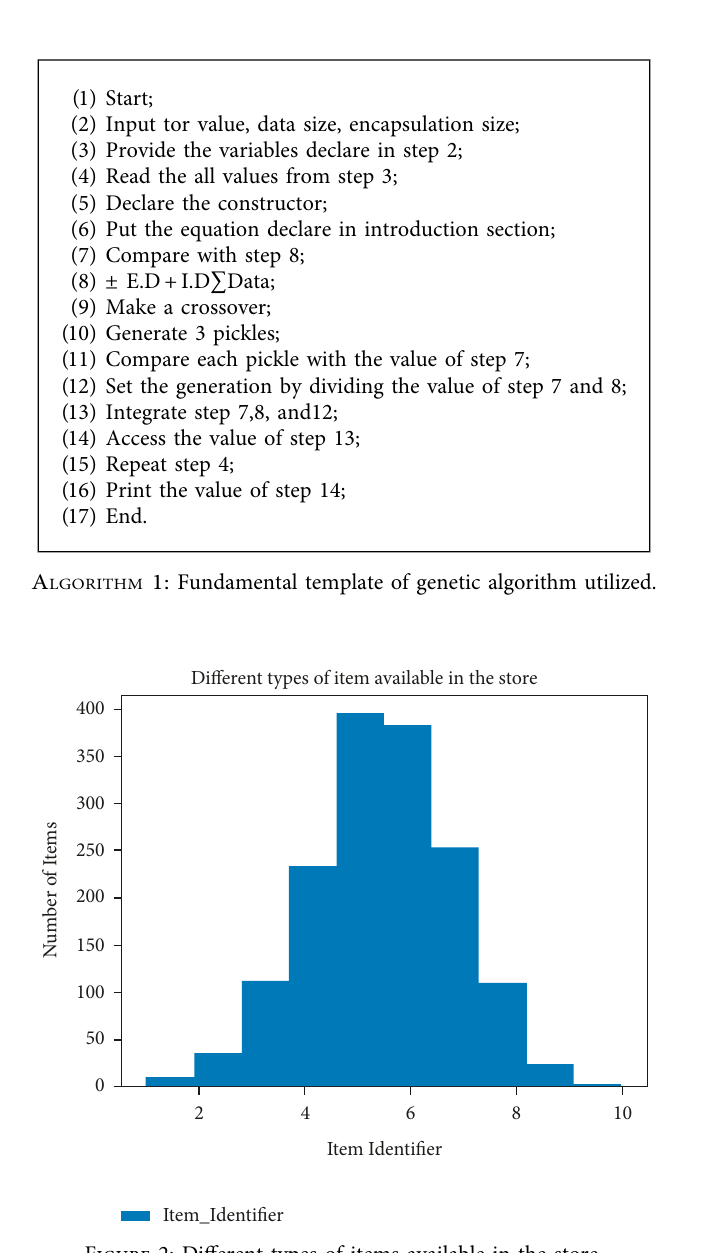
Figure 2: Different types of items available in the